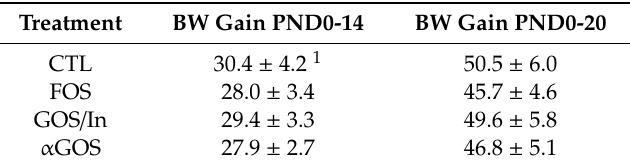
Table 2. Bodyweight gain (g) during